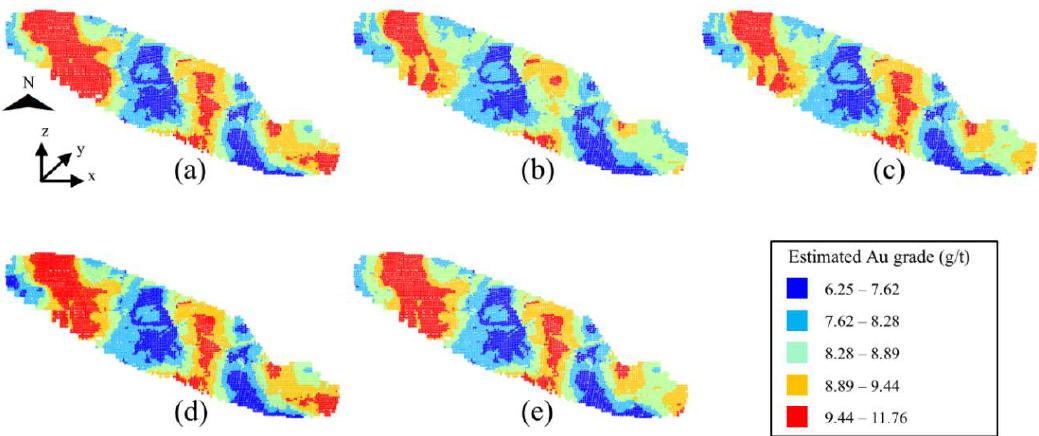
Figure 7. The kriging results of Au grade estimation using ( a ) all data or capped data by ( b ) prob top-cut, ( c ) perc top-cut, ( d ) std top-cut, and ( e ) hot spot top-cut.